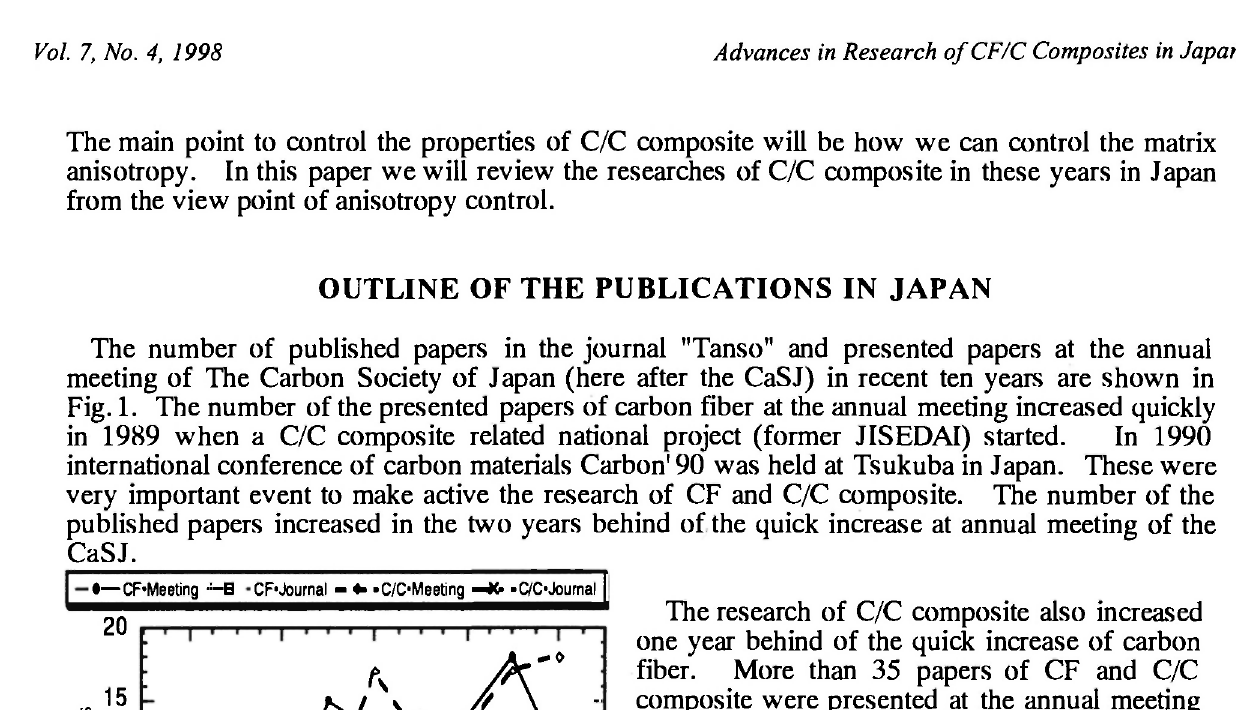
Fig.l Presented papers to the meeting and journal "Tanso" of CaSJ in these ten years.